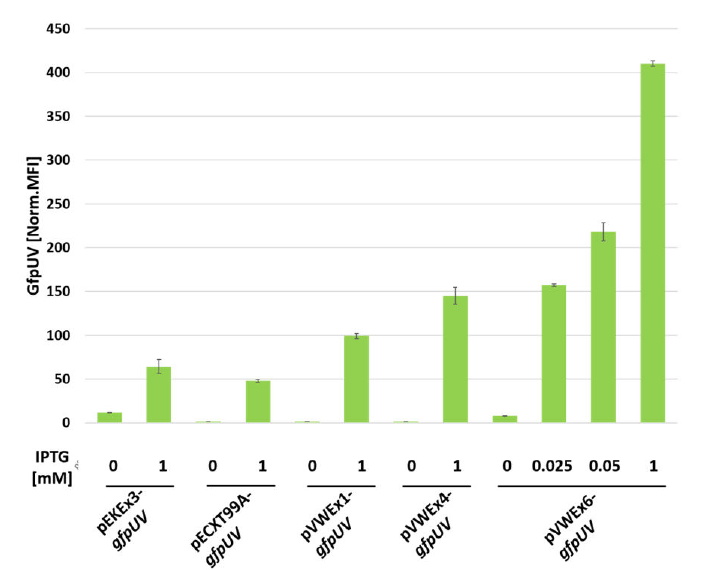
Figure 2. Fluorescence reporter assay of conventional and newly constructed IPTG-inducible expres- sion vectors in C. glutamicum WT. Vector pECXT99A- gfpUV expressed gfpUV from P trc , while P tac was used for vectors pEKEx3- gfpUV, pVWEx1- gfpUV, pVWEx4- gfpUV, and pVWEx6- gfpUV . Median GfpUV fluorescence intensities were normalized to an autofluorescent control. Mean values and standard deviations of biological triplicates are shown. Measurements were performed 20 h after inoculation in CGXII medium with 4% glucose. Newly constructed vectors: pVWEx4 and pVWEx6. Reference vectors: pEKEx3, pECXT99A, and pVWEx1. Concentration of the inductor IPTG is given in mM.